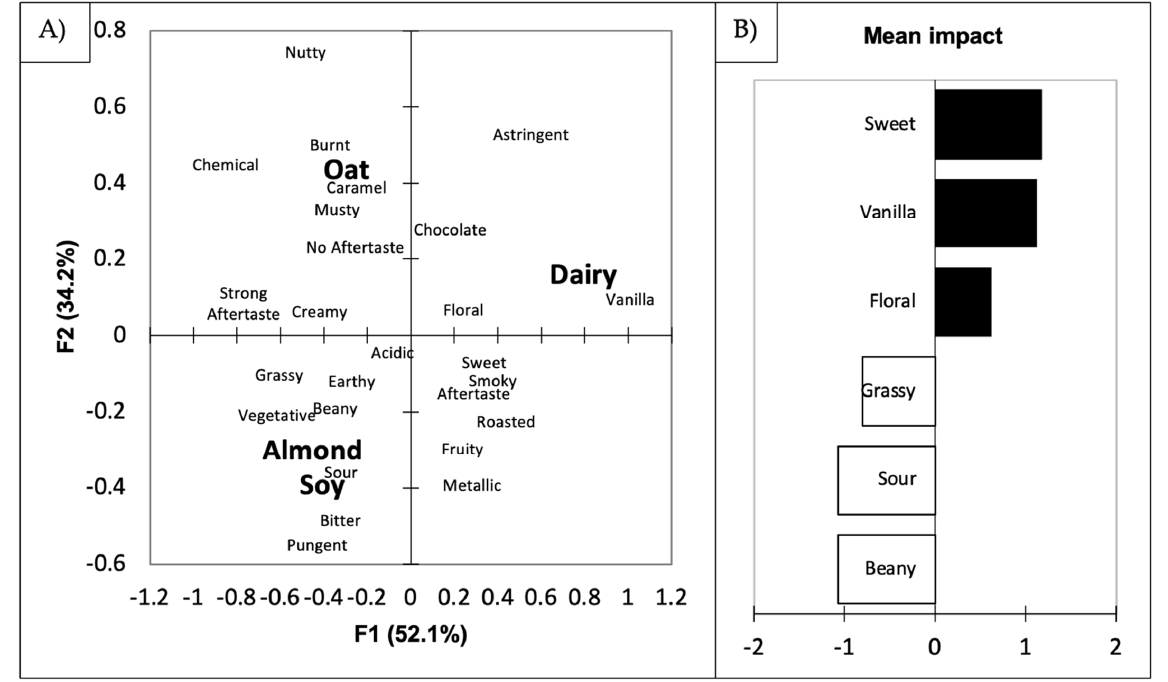
Figure 2. ( A ) Biplot representation of the sensory properties and the different coffee samples on the first two dimensions of the correspondence analysis for the dairy consumers. ( B ) Penalty analysis based on the responses to the CATA question and the dairy consumers’ overall liking scores.